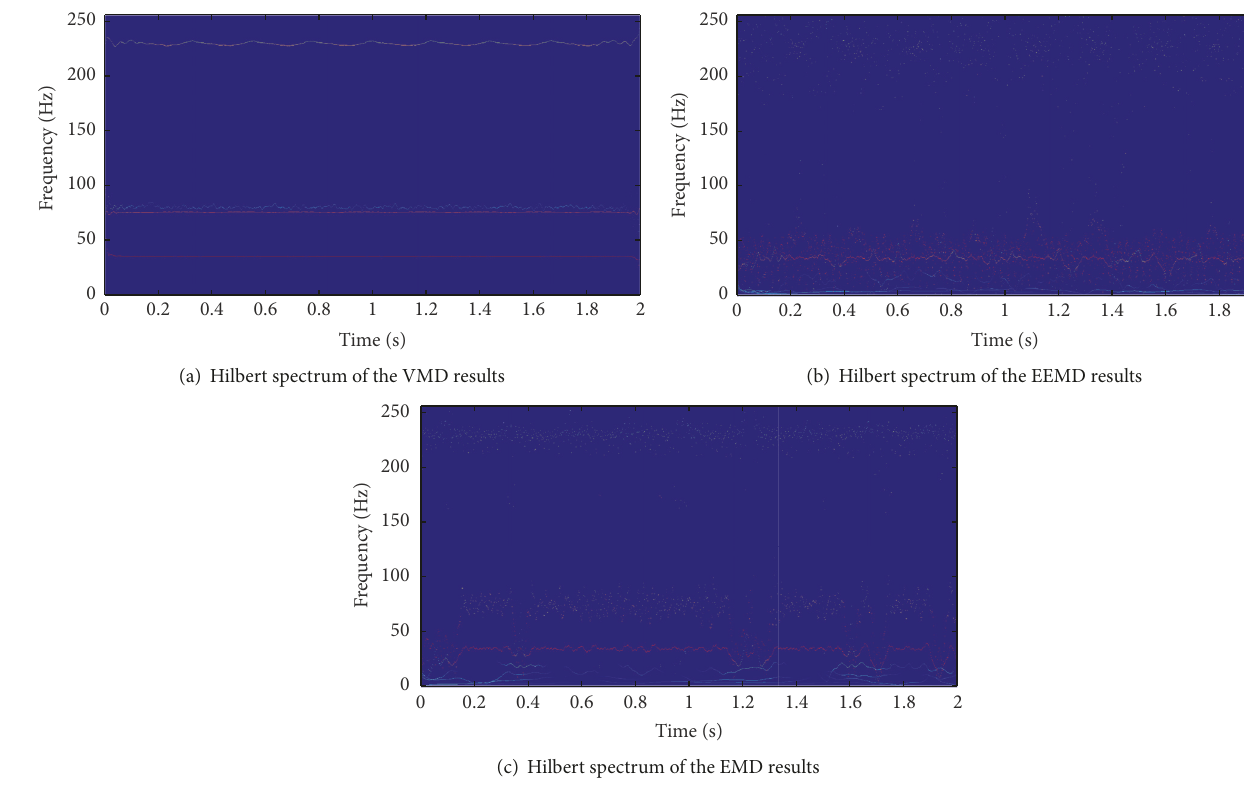
Figure 11: Hilbert spectrum of the VMD, EEMD, and EMD results of oil whip